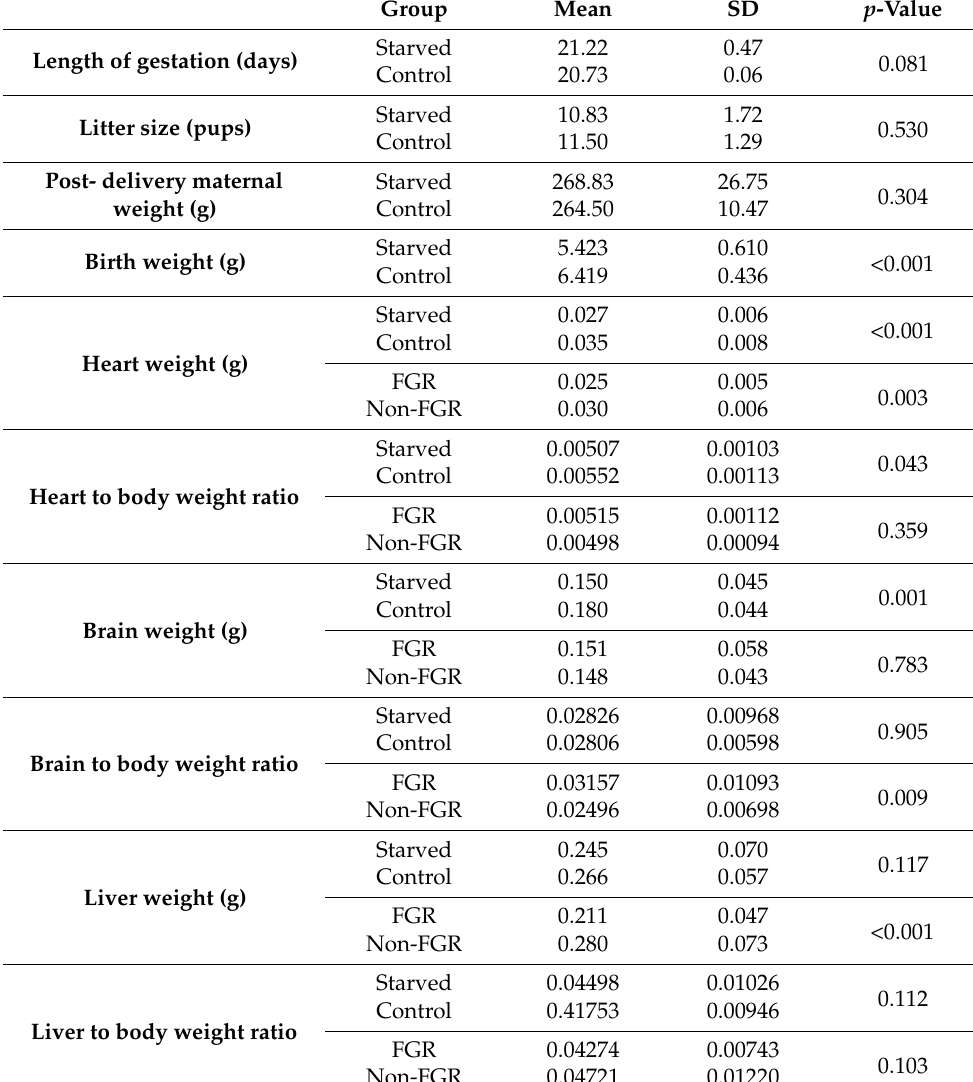
Table 1. Experimental